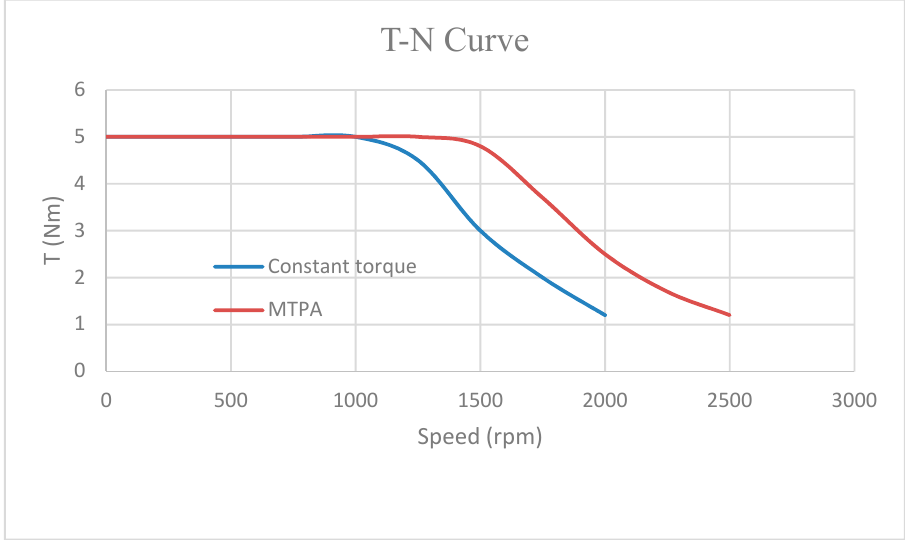
Figure 11. Curves of load vs current at 2000 rpm by fixed torque angle method and fuzzy MTPA control.